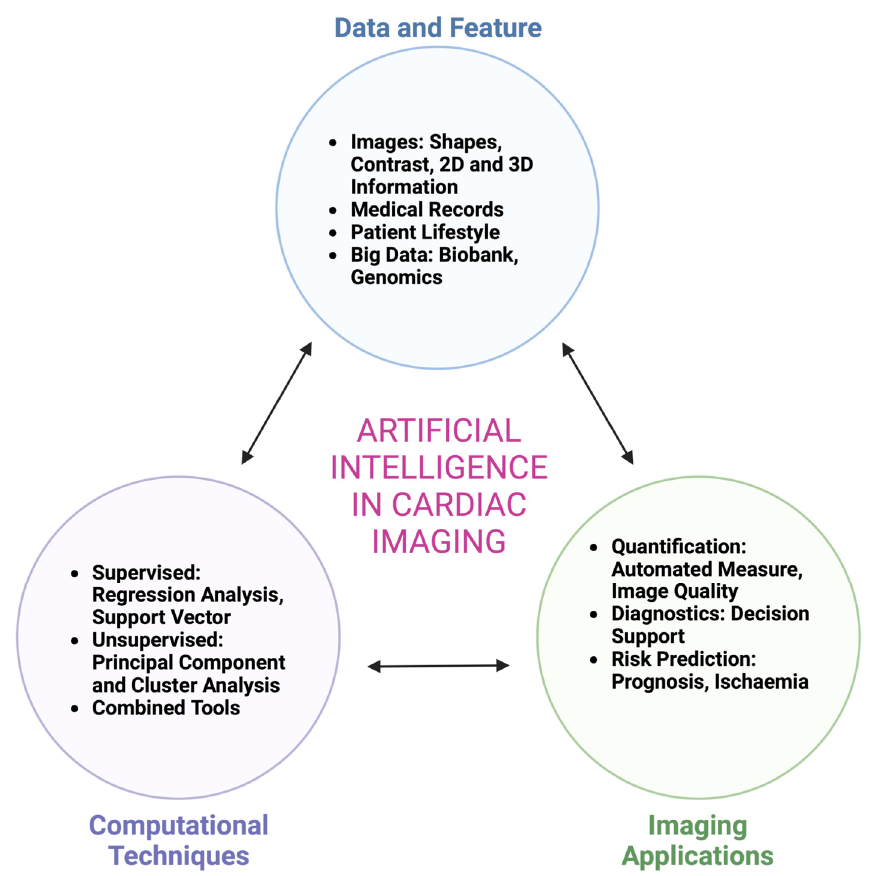
Figure 1. Steps to use artificial intelligence in cardiac imaging. [modified from Sey et al. [6]]. a. Supervised learning. Input data has a known ‘ground truth’ and is labelled, e.g.,